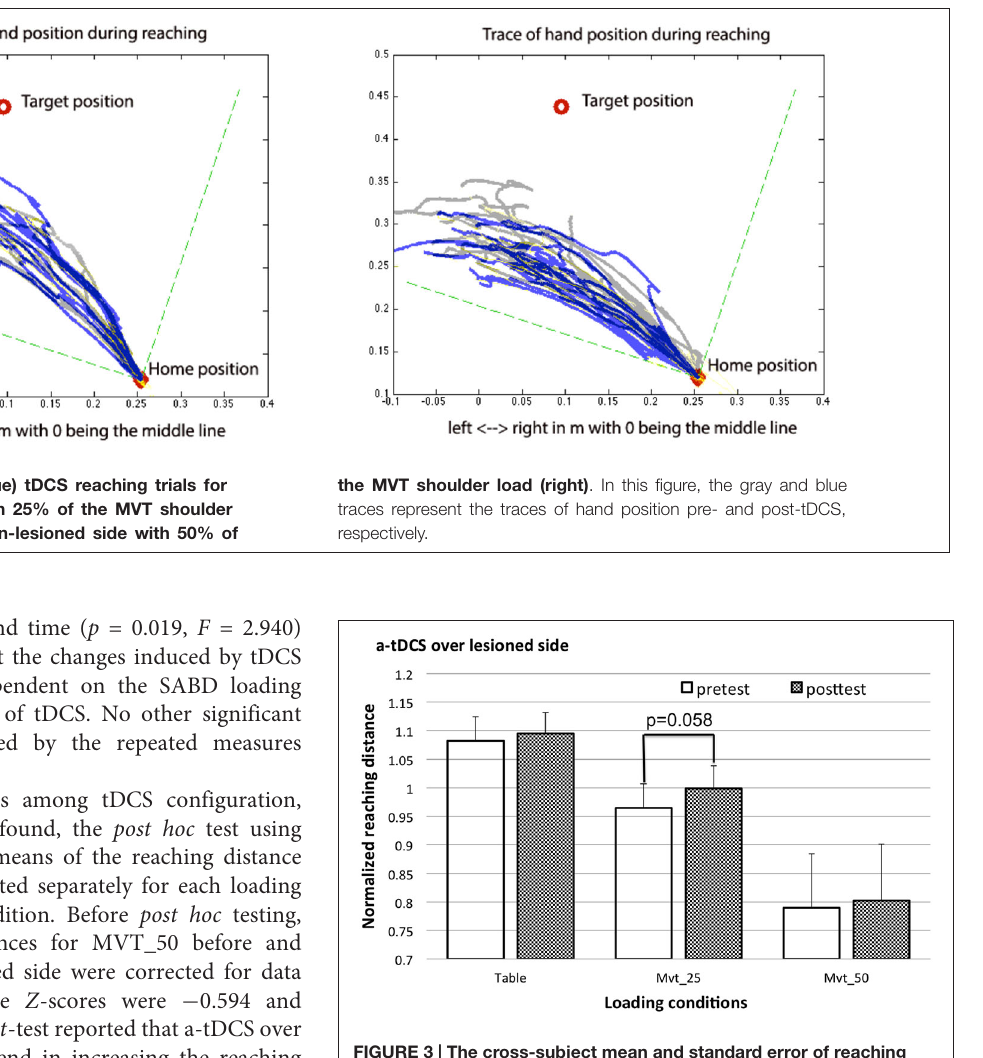
FIGURE 3 | The cross-subject mean and standard error of reaching distance pre (open bars) and post a-tDCS (shaded bars) . loading (MVT_25); and (2) changes caused by c-tDCS of the non-lesioned M1 were significantly ( p = 0.031) larger than those caused by the sham stimulation given a high level of SABD loading (MVT_50). No other significant results or clear trends were found by the post hoc